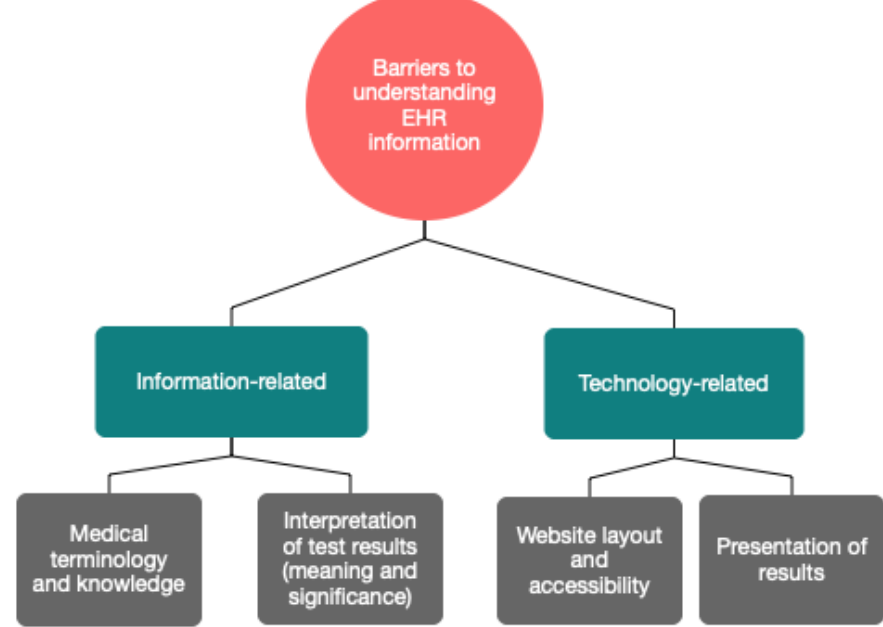
Figure 1. Thematic map of information-related and system-related barriers to patients understanding their records.